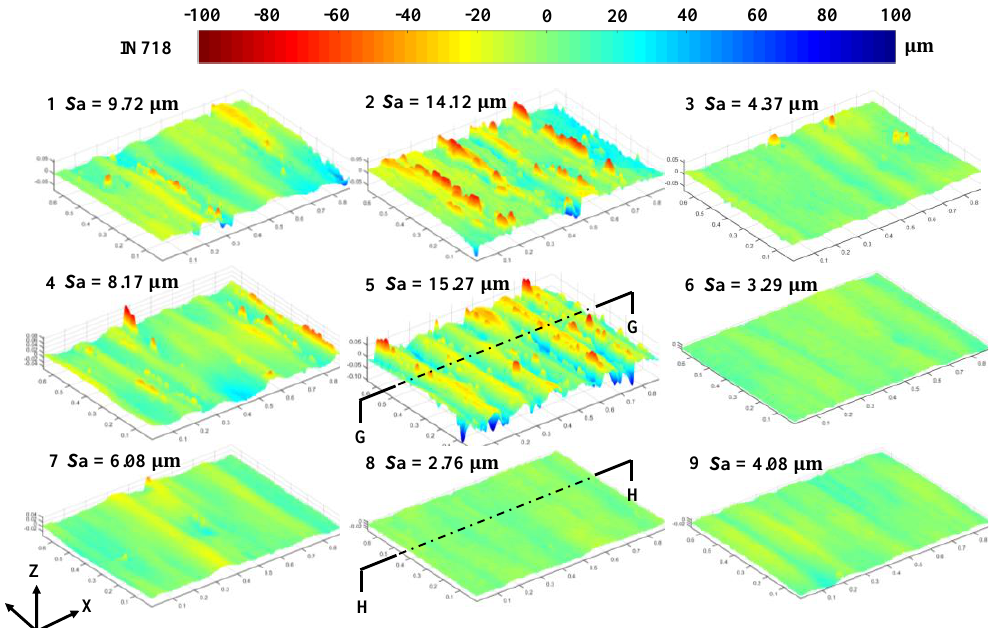
Figure 7. Three-dimensional contours of the IN718 sample after laser polishing.